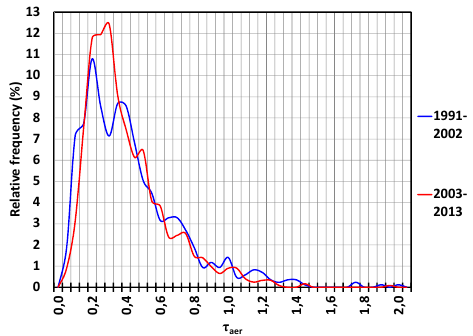
Figure 3. Relative frequency distribution of daily total ozone col- Fig. 3. Relative frequency distribution of daily total ozone column values for the two time peri- umn values for the two time periods: 1991–2002 (in blue) and ods: 1991-2002 (in blue) and 2003-2013 (in red). 2003–2013 (in red).